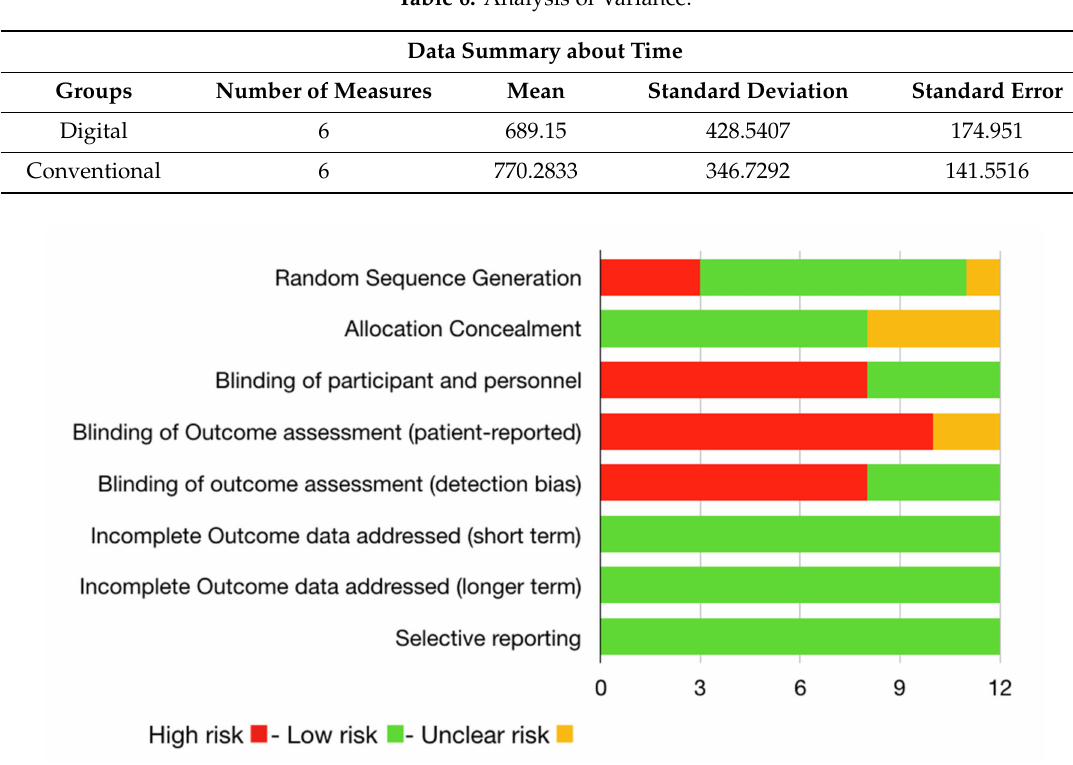
Figure 3. Risk of Bias according to Cochrane